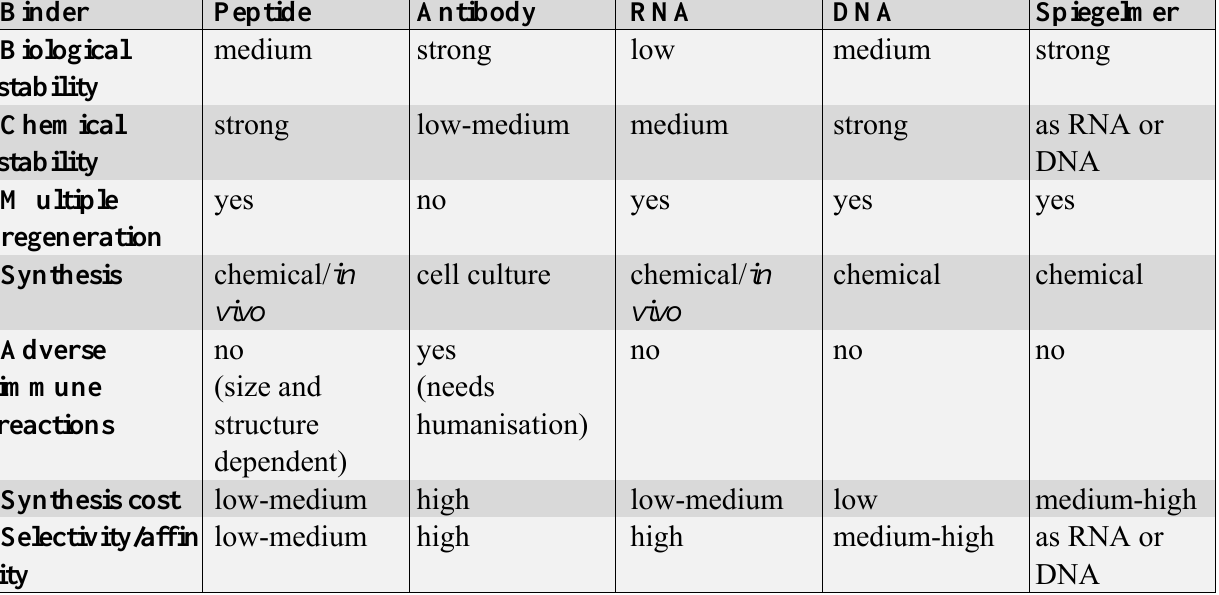
Table 2. Feature comparison of phage display and SELEX-derived